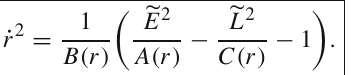
Fig. 3 In both plots, it can be seen that with increasing r the slope tends asymptotically to 1, thus corresponding to an asymptotically flat geometry. Also, the slope approaches 1 even faster when the value of n